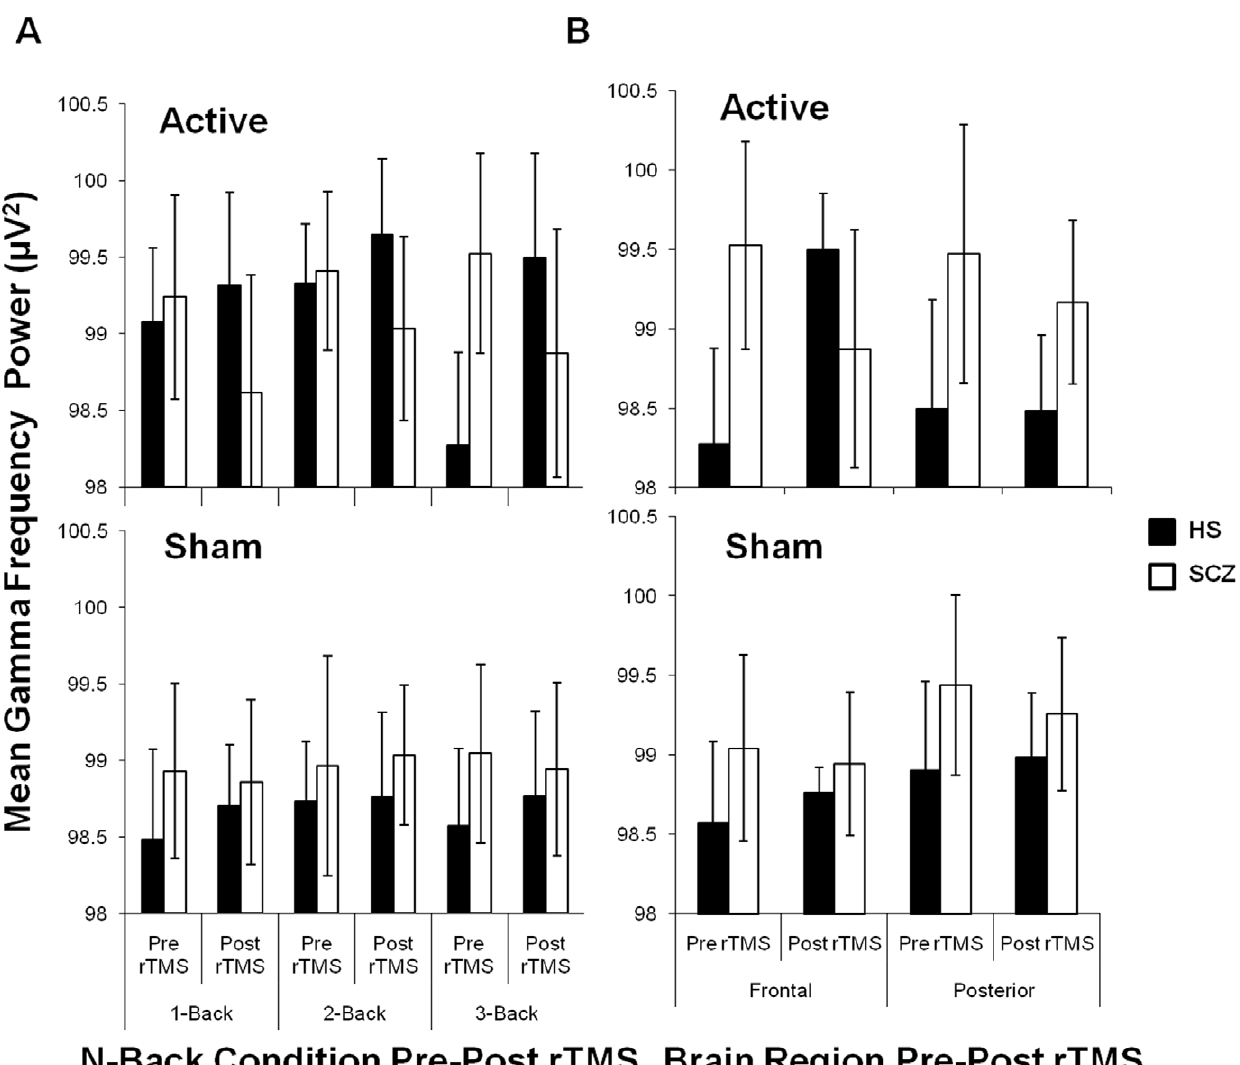
Figure 3. Mean log transformed gamma oscillatory power ( c ; 30–50 Hz; uV 2 ) for target correct (TC) and non-target correct (NTC) responses during the N-back task pre-post rTMS in healthy subjects (HS; N=22) versus patients with schizophrenia (SCZ; N=24) (A). Mean log transformed c oscillatory power (uV 2 ) for target correct (TC) and non-target correct (NTC) responses during the 3-back condition measured from the frontal and parieto-occipitalbrain regions pre-post rTMS in patients with schizophrenia (SCZ; N=24) and healthy subjects (HS; N=22) (B). Bars represent ( 6 ) 1 standard deviation.